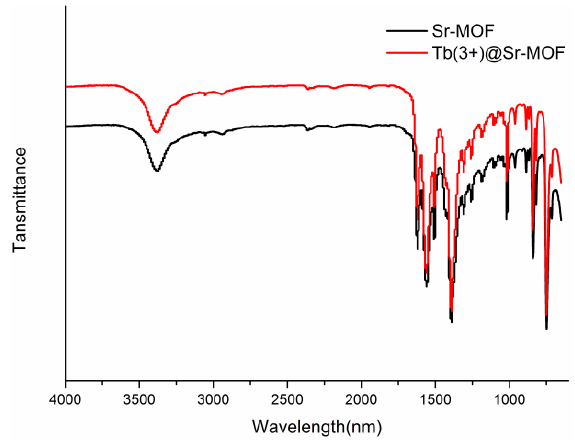
Figure 4. IR spectra of Sr-MOF and Tb(3+)@Sr-MOF.